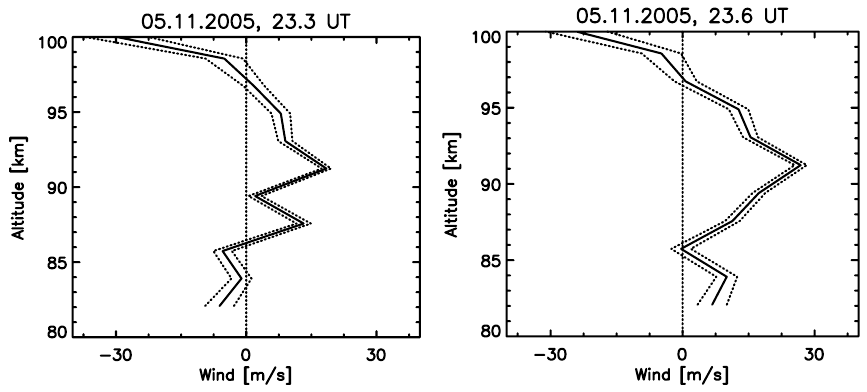
Fig. 5. 15min averaged zonal winds measurement on 5 November 2005 observed by ALOMAR Weber Na lidar in beam 1 (pointed 20 ◦ W of zenith) (positive values correspond to eastward